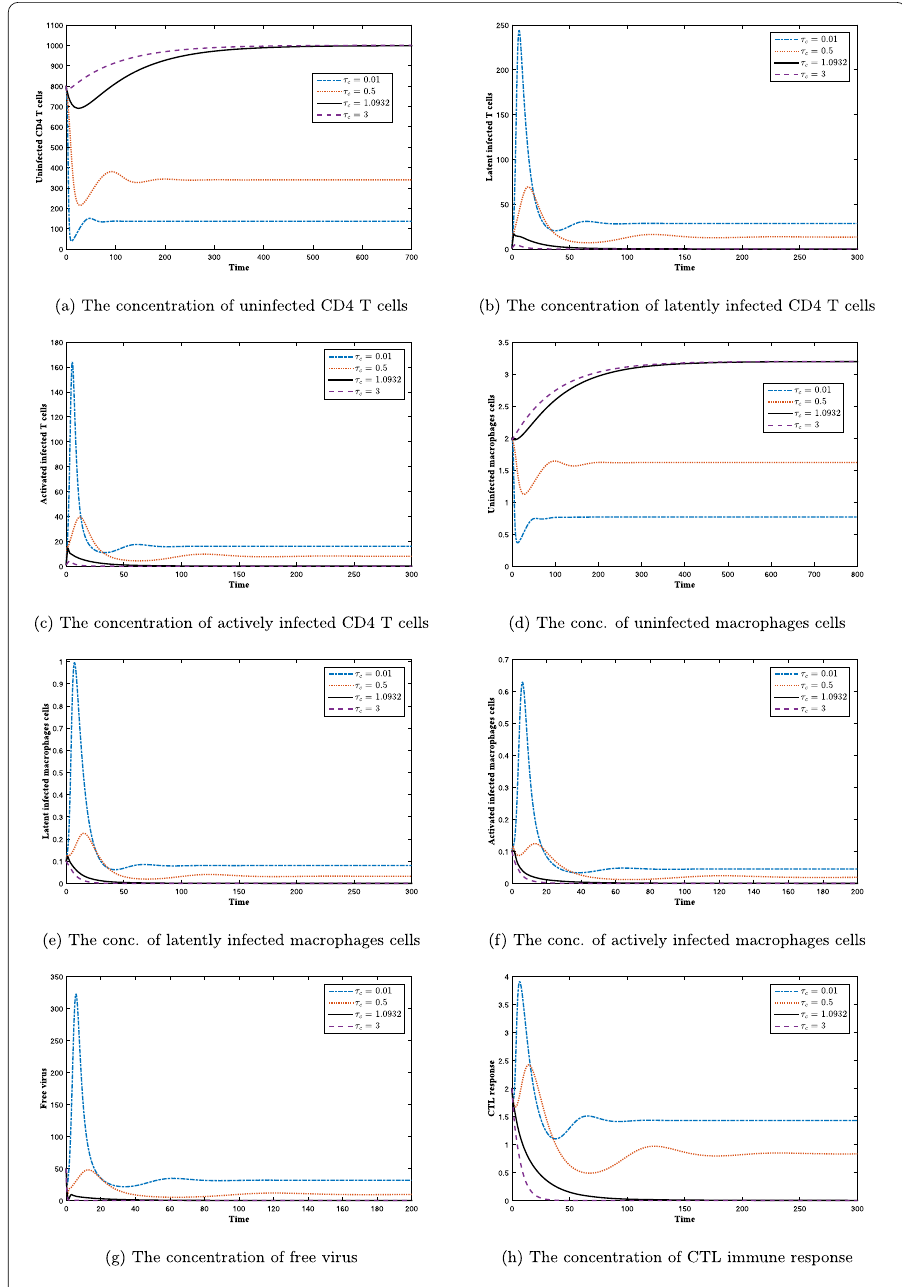
Figure 2 The evolution of model (6)–(13) with varied τ c